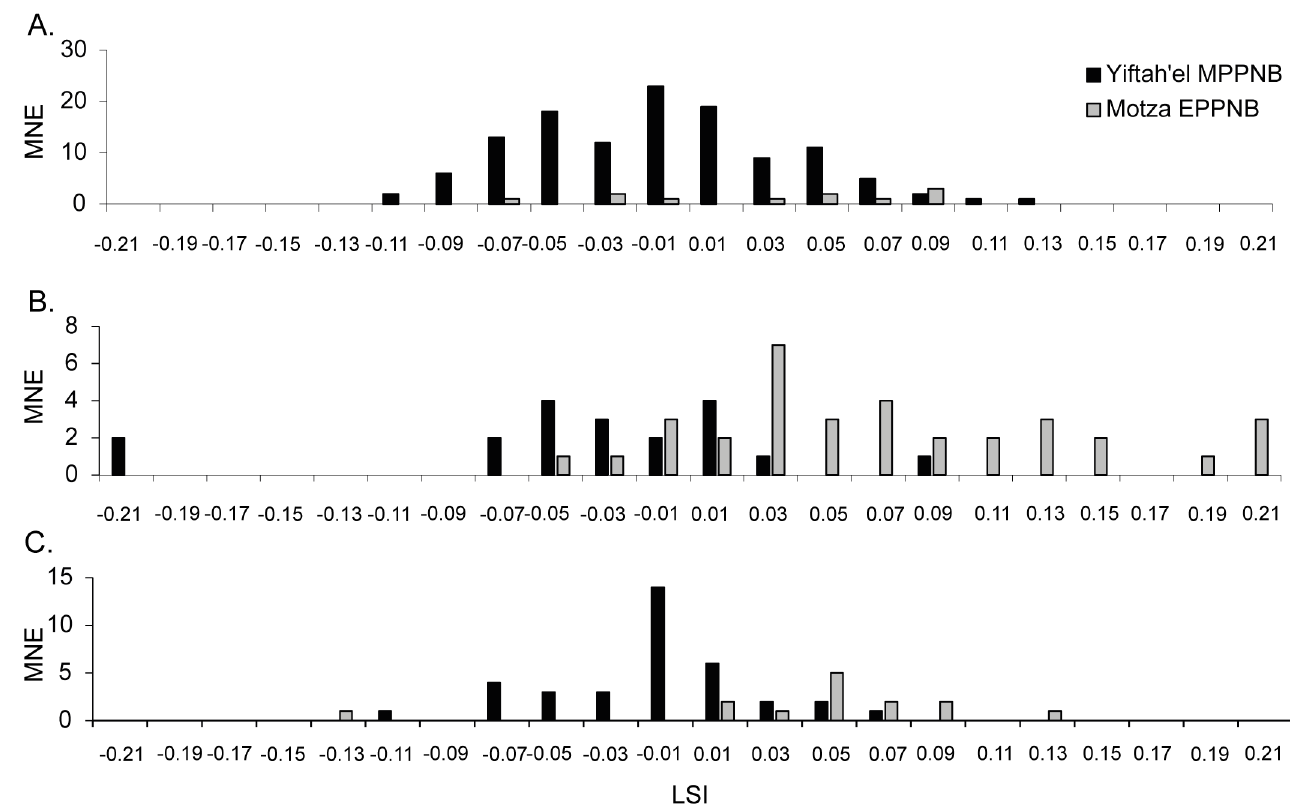
Fig 6. LSI distribution of (A) Capra (MPPNB Yiftah'el n = 122; EPPNB Motza n = 11). (B) Sus (MPPNB Yiftah'el n = 19; EPPNB Motza n = 34). (C) Bos (MPPNB Yiftah'el n = 36; EPPNB Motza n = 14).